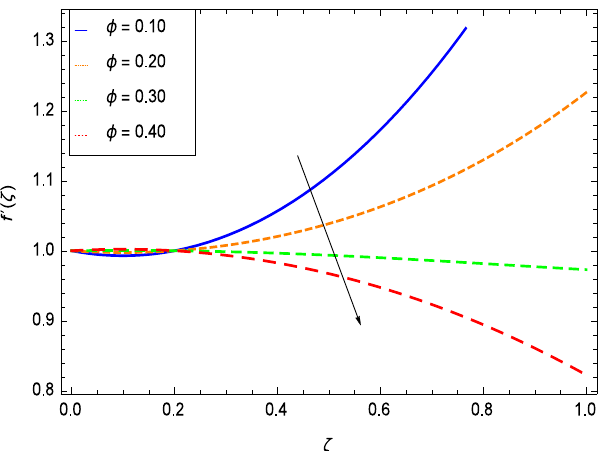
Figure 5. Flow layer at h = − 3.00, β = 0.10, n = 1.50, We = 0.50, S = 0.50, M = 2.00, A = π enhancement in φ .